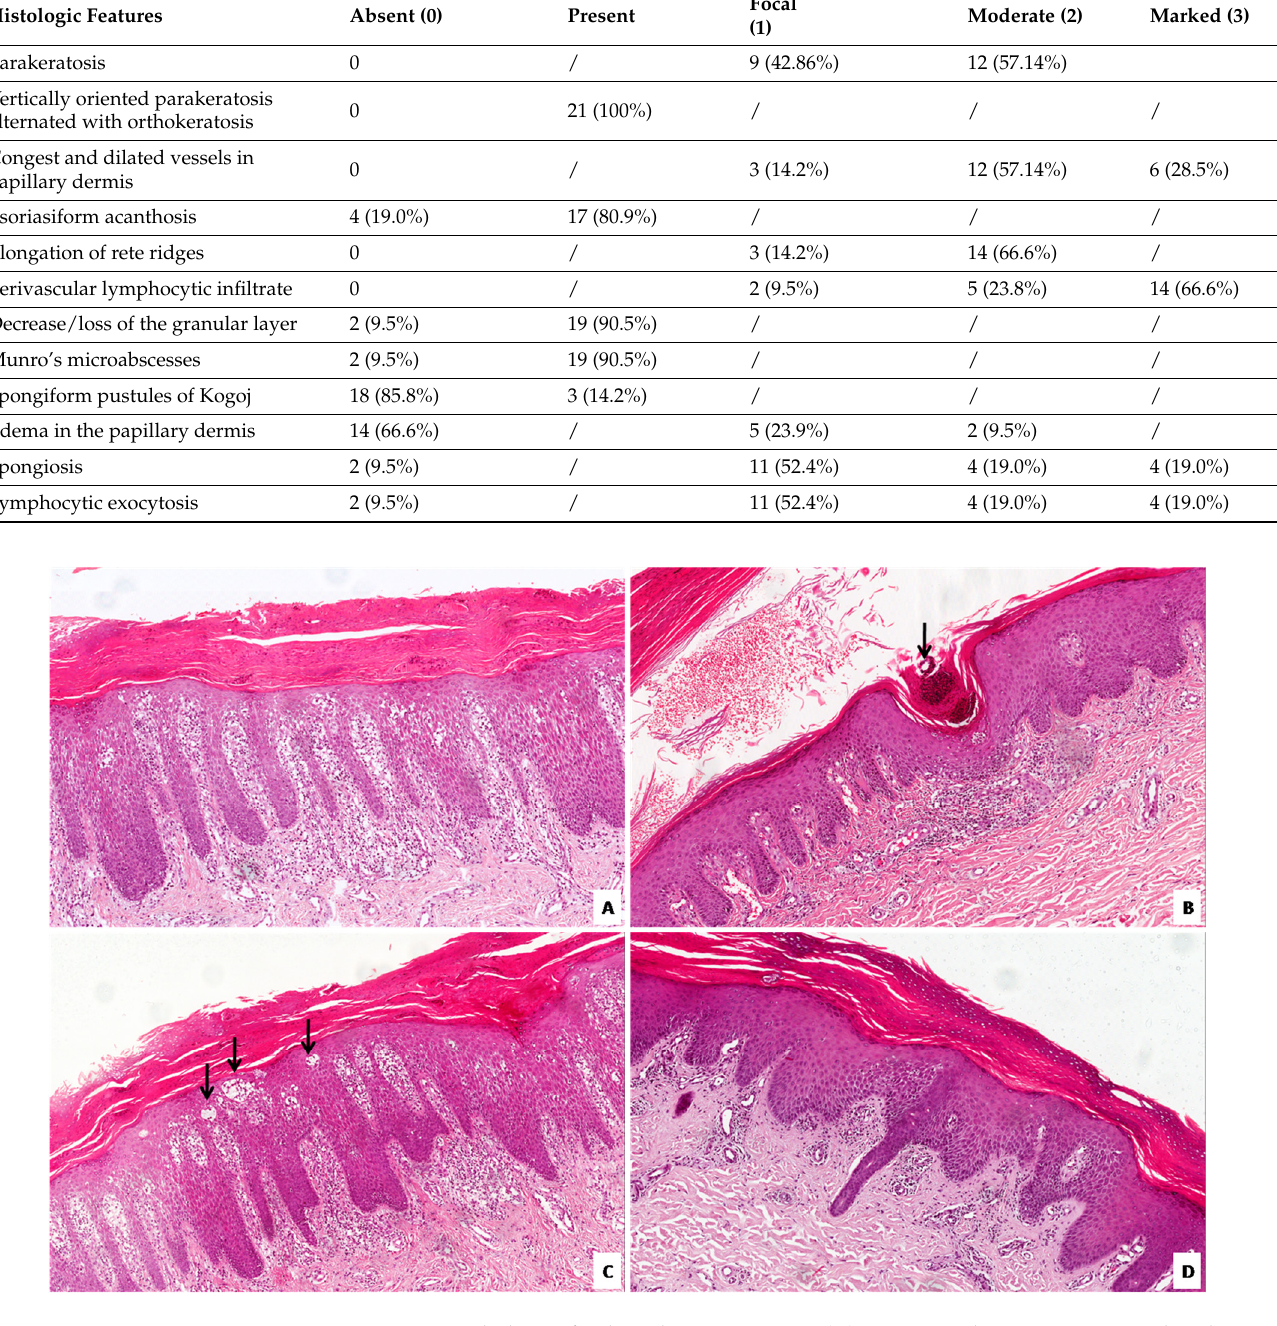
Figure 1. Histopathology of palmoplantar psoriasis. ( A ) Hyperparakeratosis associated with pso- riasiform acanthosis with thinning of the suprapapillary plate and partial loss of the granular layer is seen; dilated vessels and moderate perivascular lymphocytic infiltrate are also shown at the papillary dermis. ( B ) Medium magnification showing a case of palmoplantar psoriasis with a Munro’s microabscess in the stratum corneum (arrow). ( C ) Marked spongiosis along with spongiform pustules of Kogoj (arrows) is seen. ( D ) Medium magnification showing spongiotic features associated with lymphocytic exocytosis in palmoplantar psoriasis. (Original magnifications: A-D, 200×).